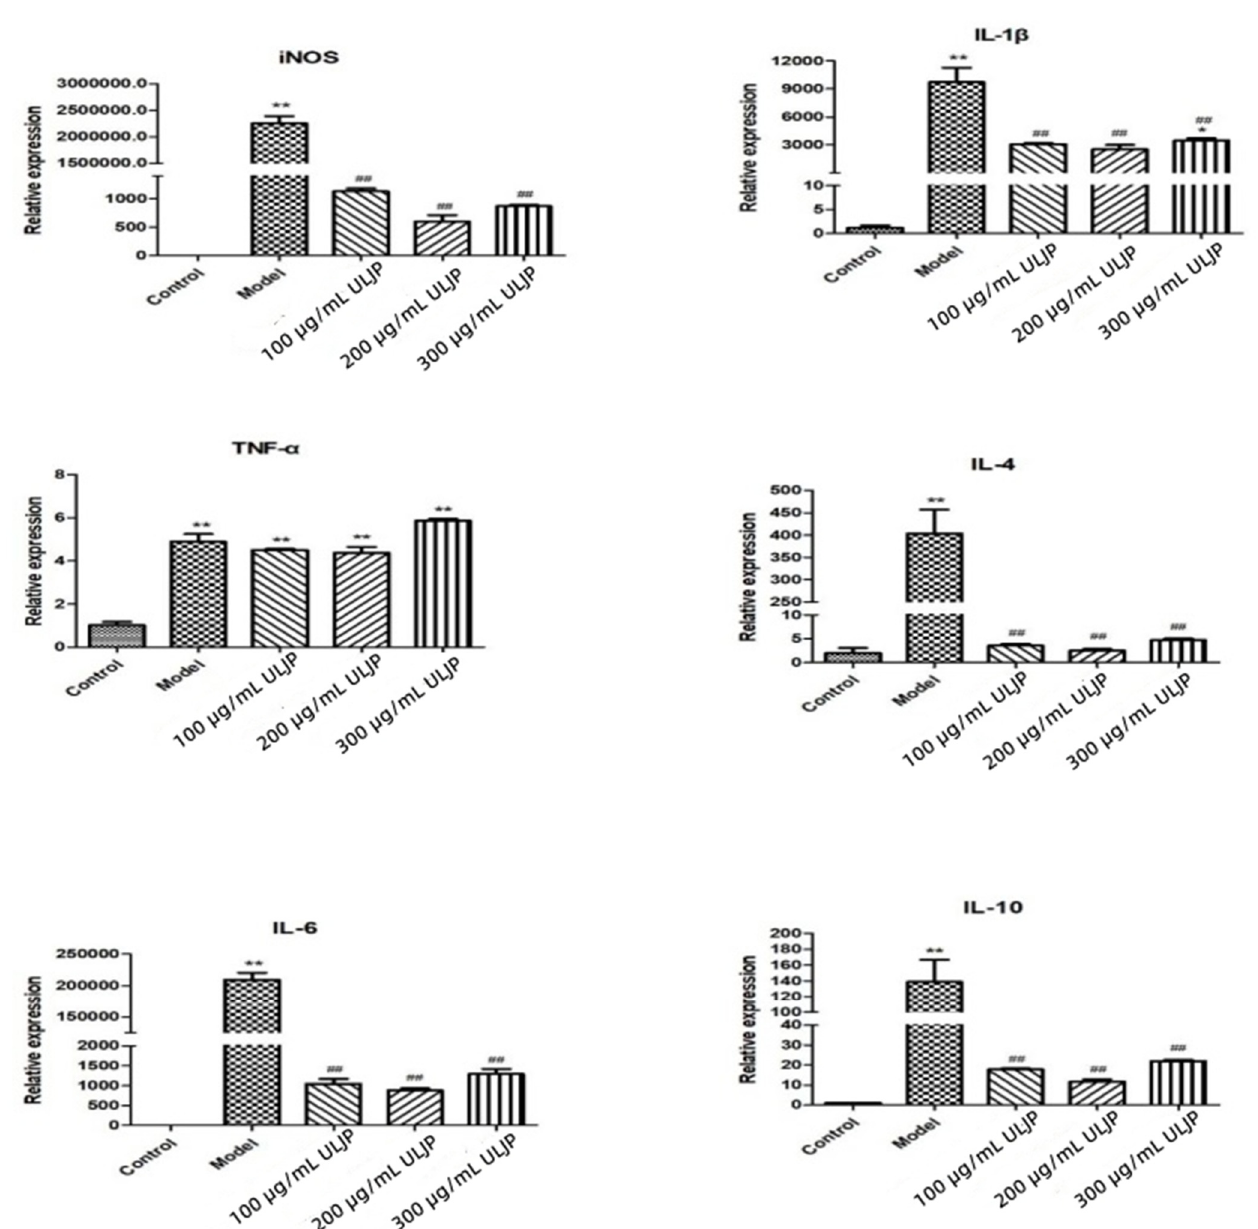
Figure 10. Effects of ULJP on mRNA expression levels of inflammatory factors in LPS-induced RAW264.7 macrophages. (## p < 0.05; ** p < 0.01; * p <